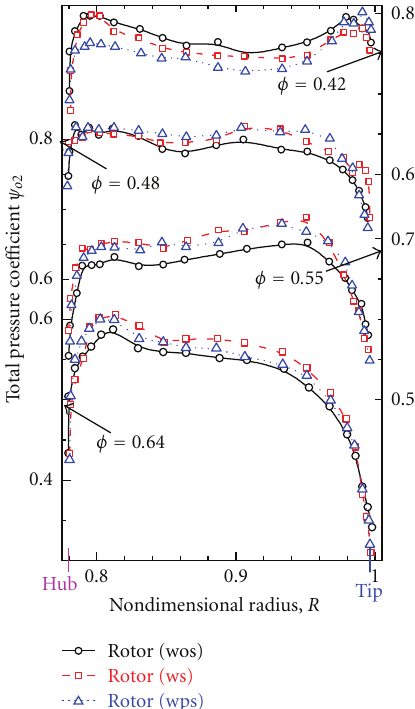
Figure 5: Radial distribution of total pressure coe ffi cient at the ro- tor